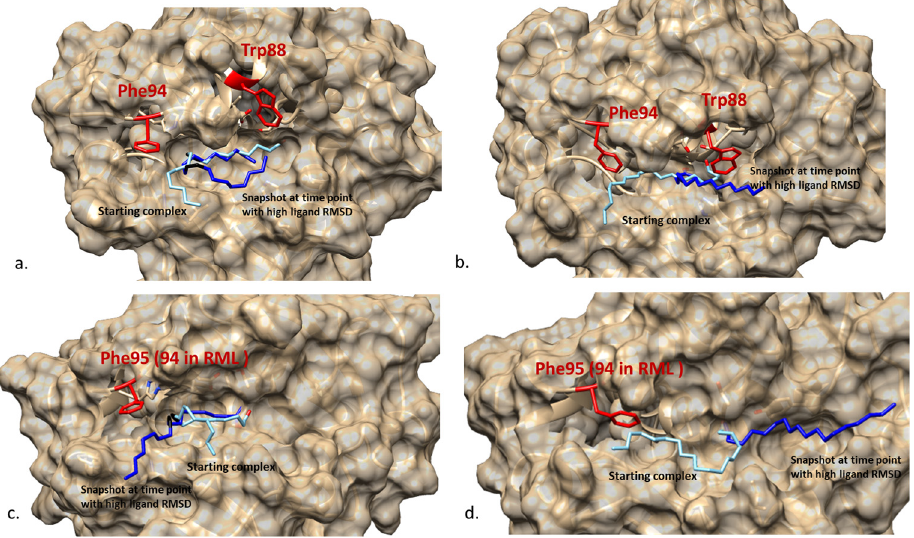
Figure 7. Superposition of the “fixed” starting complexes (ice blue ligand) of MD simulation and the snapshot (bright blue ligand) generated at the time point where the amplitude of the variation of either ligand movement RMSD (stearic acid) or ligand conformation RMSD (oleic acid) is the highest. ( a ). RMOL (snapshot at 14 ns); ( b ). RMST (snapshot at 13 ns); ( c ). ROOL (snapshot at 24.5 ns); ( d ). ROST (snapshot at 40 ns). Phe94 (Phe95 for ROL complex) and Trp88 which shows limitation on the ligand movement are marked as red on the figure.